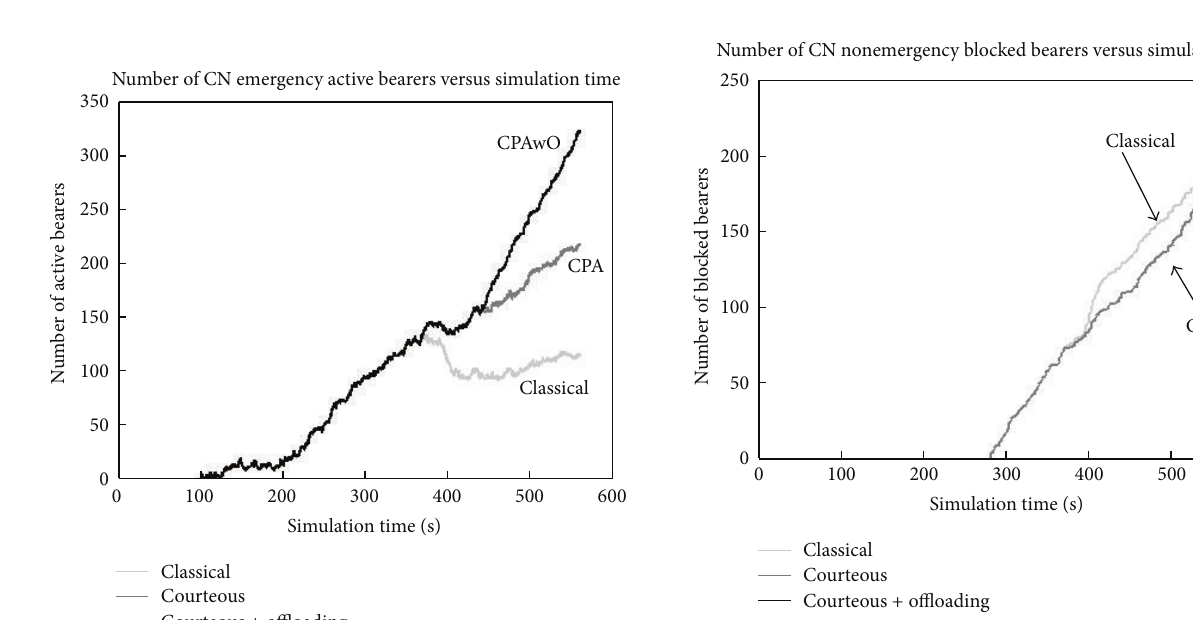
Figure 7: Number of CN nonemergency active bearers.